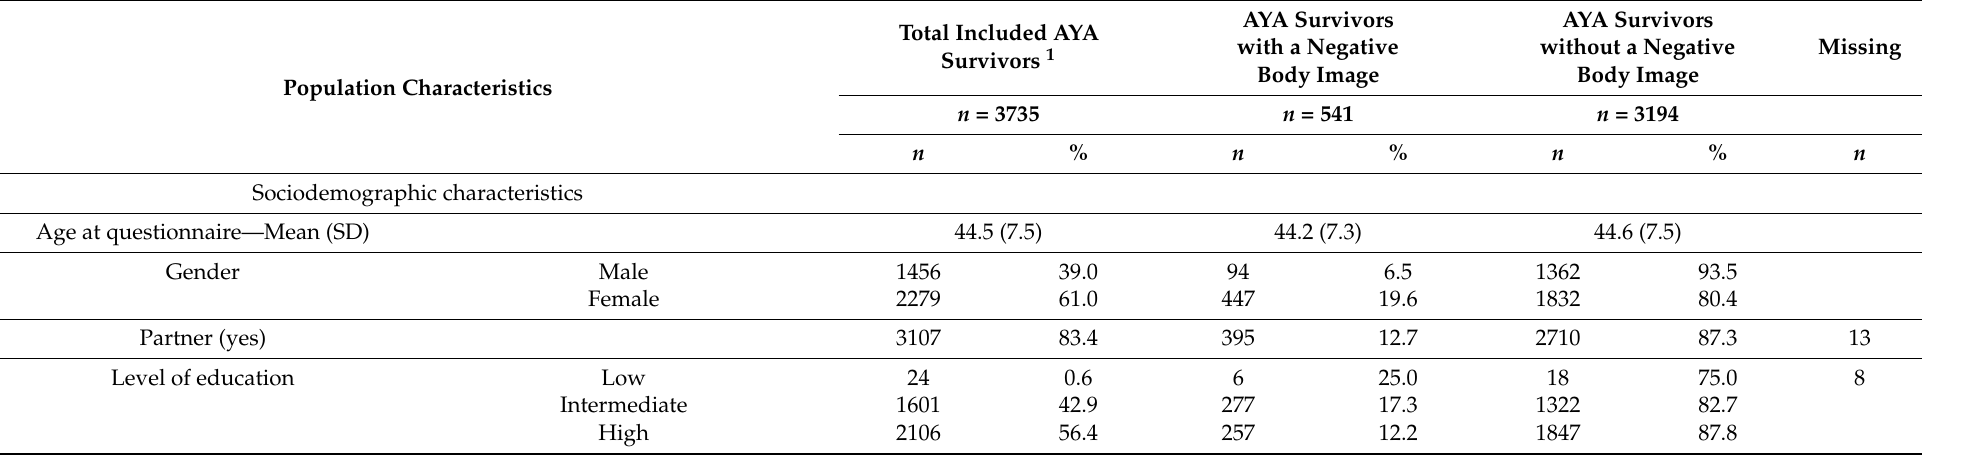
Table 2. Sociodemographic, clinical, and psychosocial characteristics of the included AYA